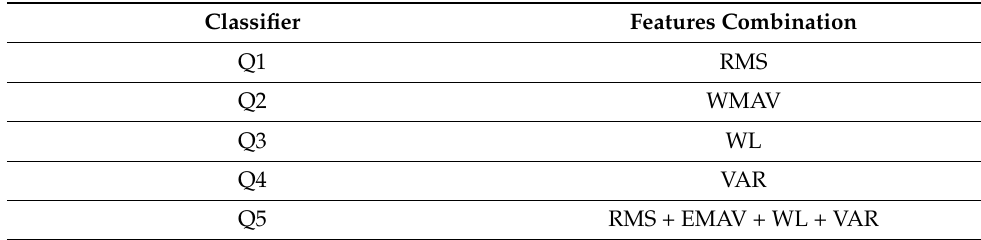
Table 2. Definition of classifiers based on the features